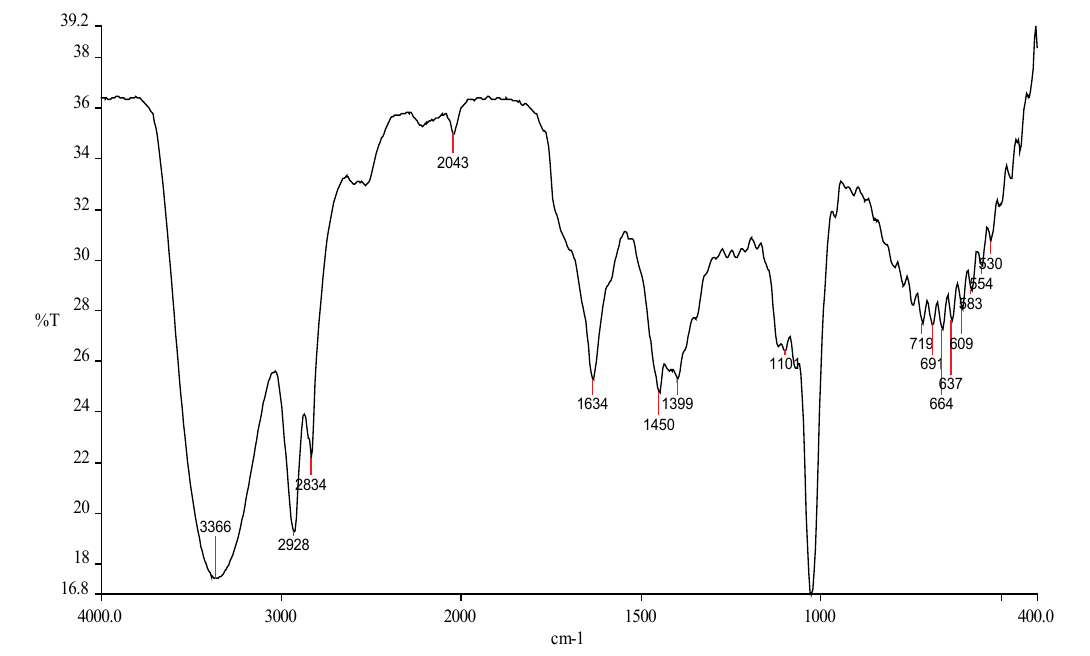
Figure 3. FTIR spectra of methanolic extract of Cassia spectabilis (KBr disc), cm -1 .